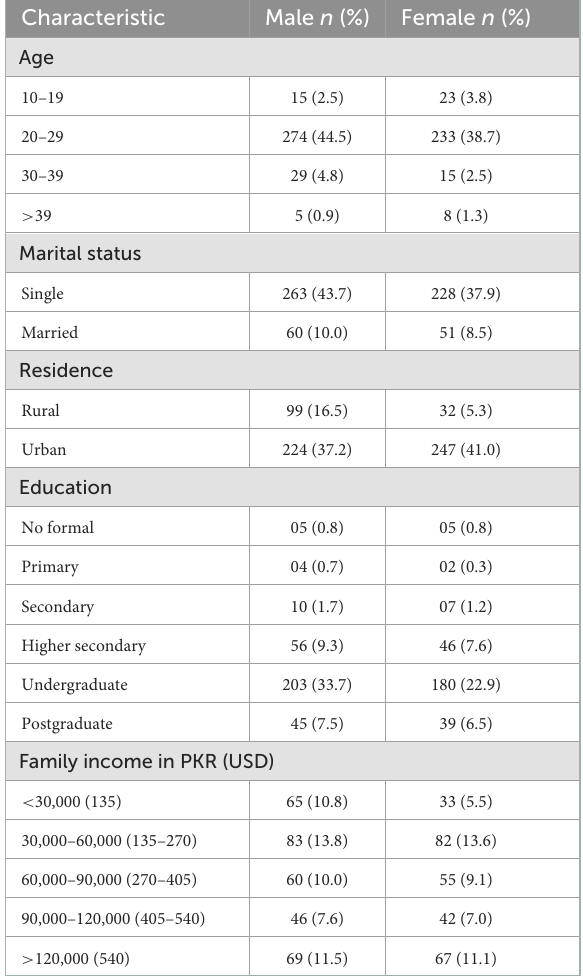
TABLE 1 Sociodemographic characteristics of study participants ( N = 602).